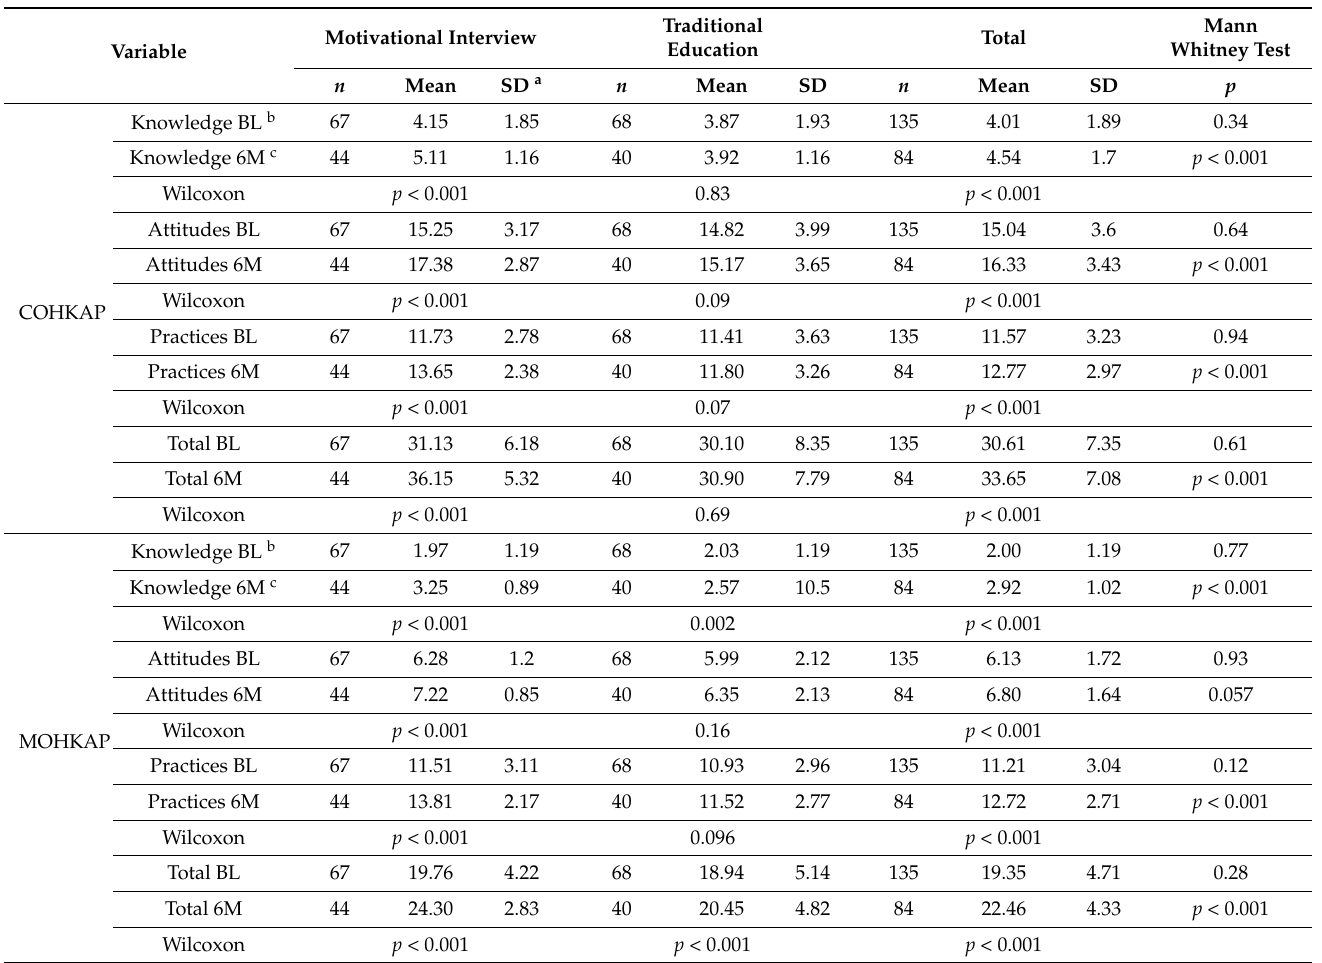
Table 2. Comparison of oral healthcare knowledge, attitudes, and practices between control and experimental groups six months after intervention. CAISES Le ó n, Guanajuato, M é xico,